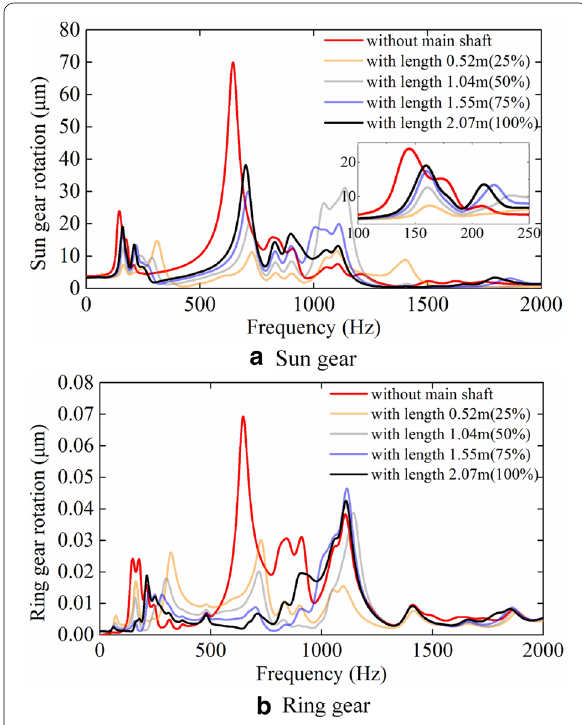
Figure 9 Dynamic torsional displacements